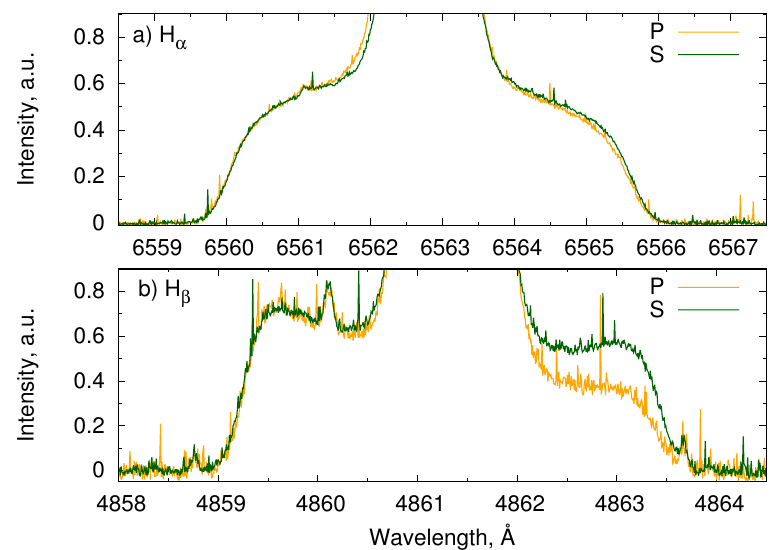
Figure 10. Polarization by light reflection in the line shapes of the Balmer- α ( a ) and Balmer- β lines ( b ) in front of a Cu mirror. The applied potential was − 120 V, and the spectra were measured at the angle of 70 ◦ as shown in Figure 4. The spectra measured with the direction of polarization perpendicular to the plane of incidence are shown using the green line ( S ) and with direction of polarization parallel to it as the orange line ( P ). The Balmer- α spectrum was taken from [18].